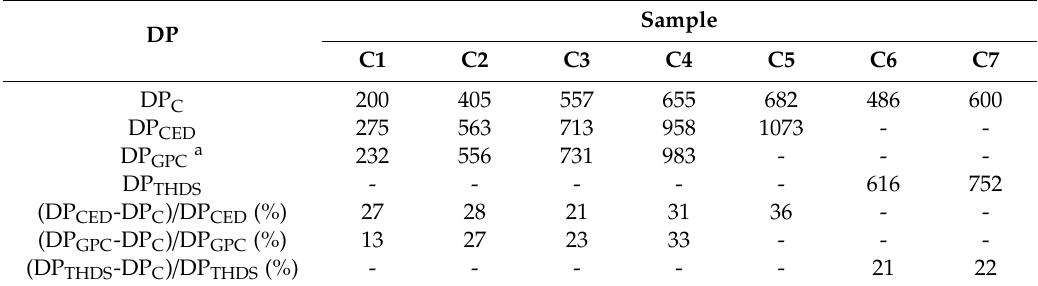
Table 4. The DP values of cellulose samples C1–C7 determined by di ff erent methods.